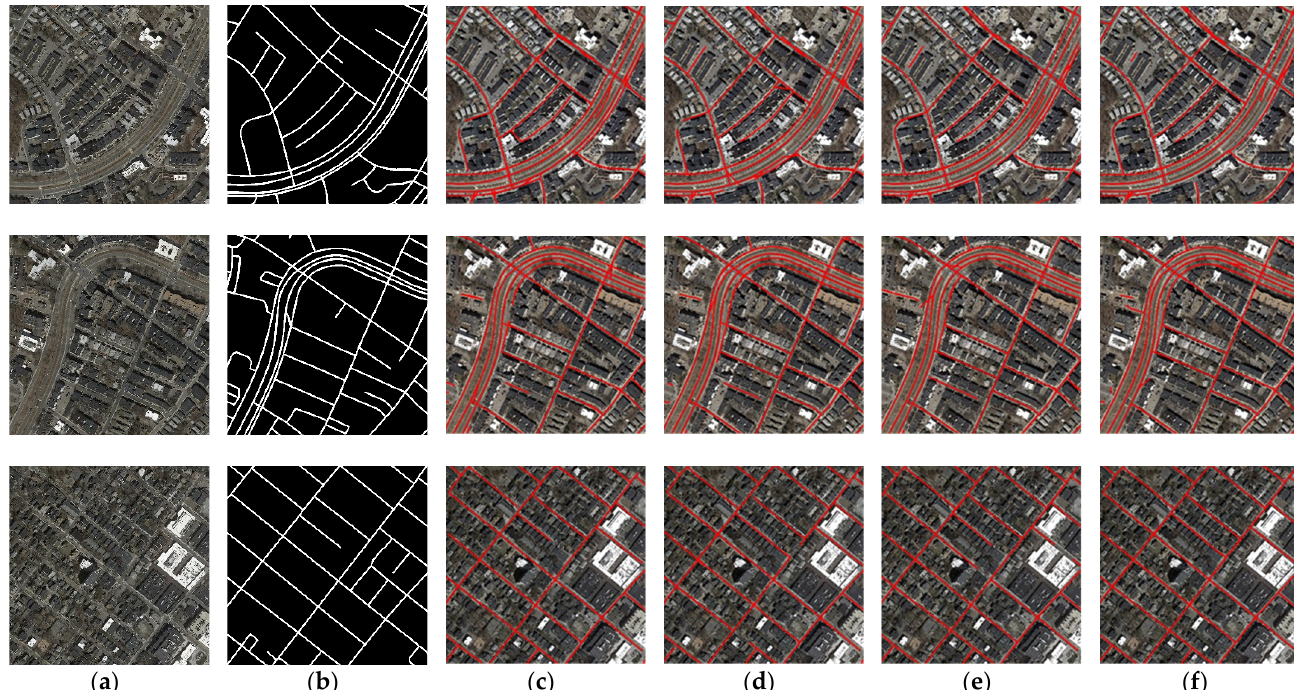
Figure 11. Visual comparisons of road extraction results with different models on the RoadTracer dataset: ( a ) input test image; ( b ) corresponding ground truth image; ( c ) results using the LinkNet; ( d ) results of D-LinkNet; ( e ) results of Road- Tracer; ( f ) results of proposed